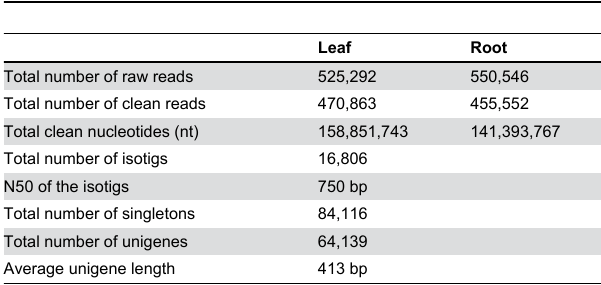
Table 1. Summary of sequencing data of S. miltiorrhiza root and leaf